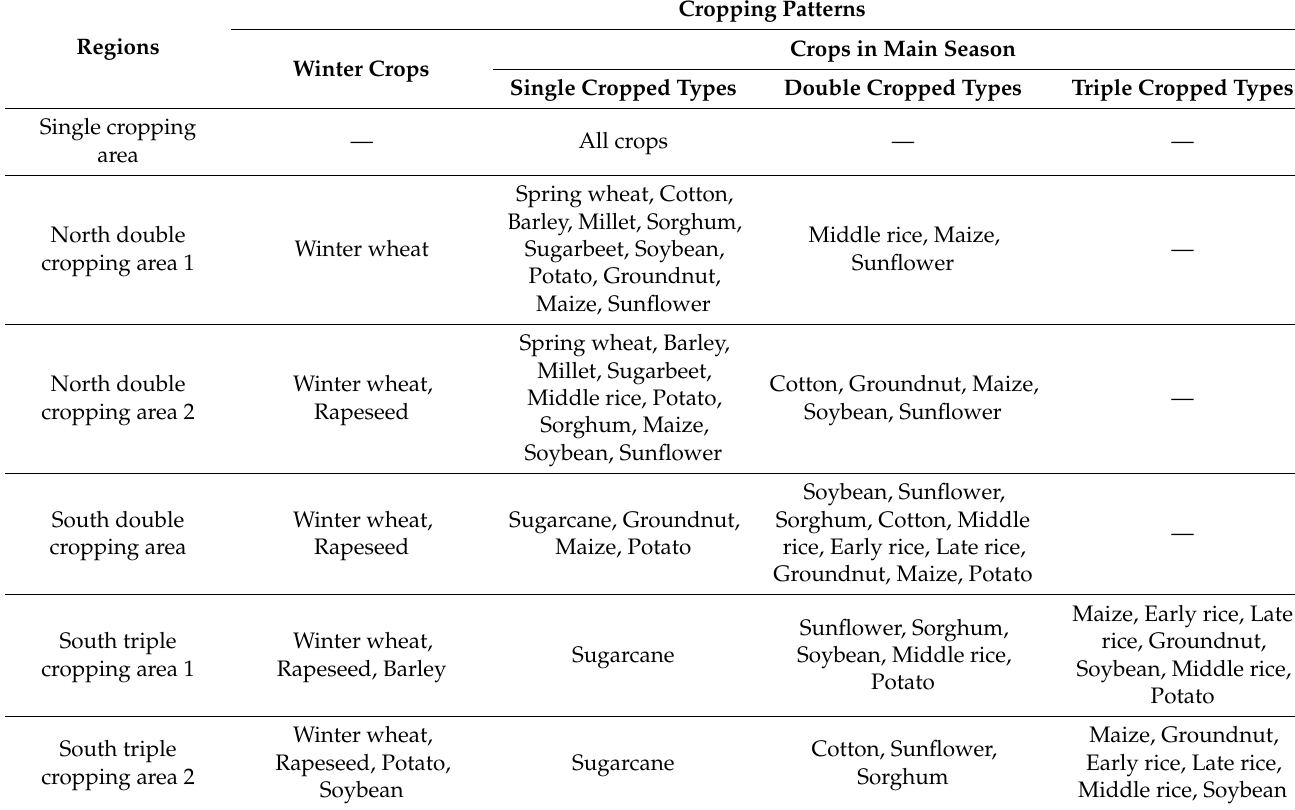
Table 1. Cropping patterns in the six agricultural